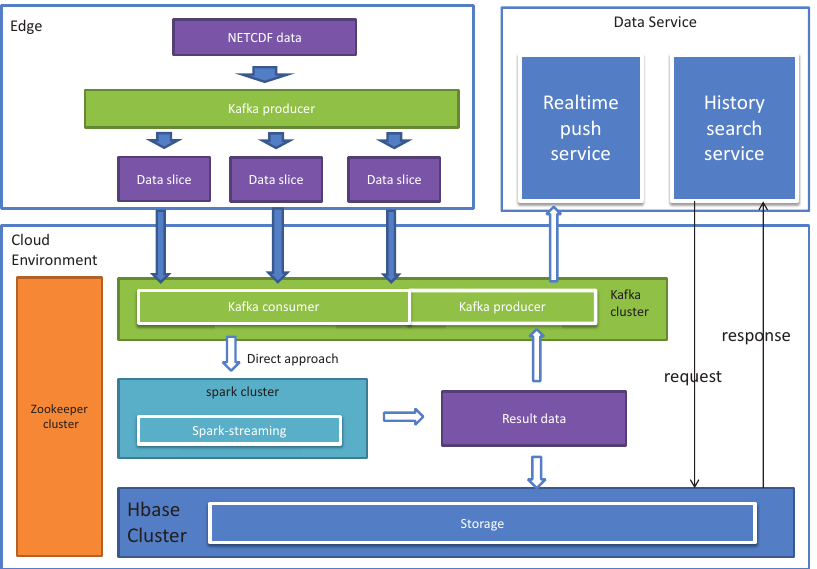
Figure 9. Technical architecture of the application. In the experiment, data fluidization was performed on the producer side of Kafka on the data source, and parallel computation was performed on Spark-Streaming. Dataflow gates were configured on the producer side of Kafka in the cluster